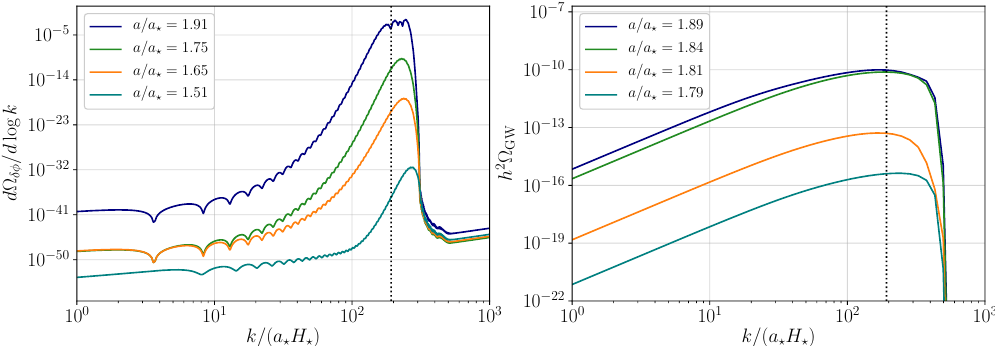
Figure 11: The spectrum of the excited ALP modes (left) and the resulting GWs (right), normalized to the total energy density at the start of the simulation. The coloured curves correspond to snapshots of the spectrum at different times. The dot- ted black line denotes the analytic estimate of the peak momentum k